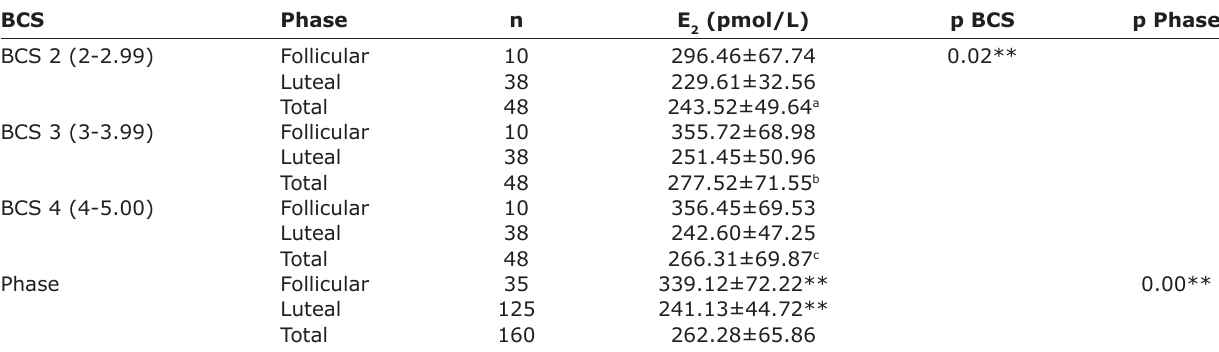
Table-4: Estrogen (E2) levels of Saanen goats in each body condition score during the phases of estrous cycle (mean±SD). BCS